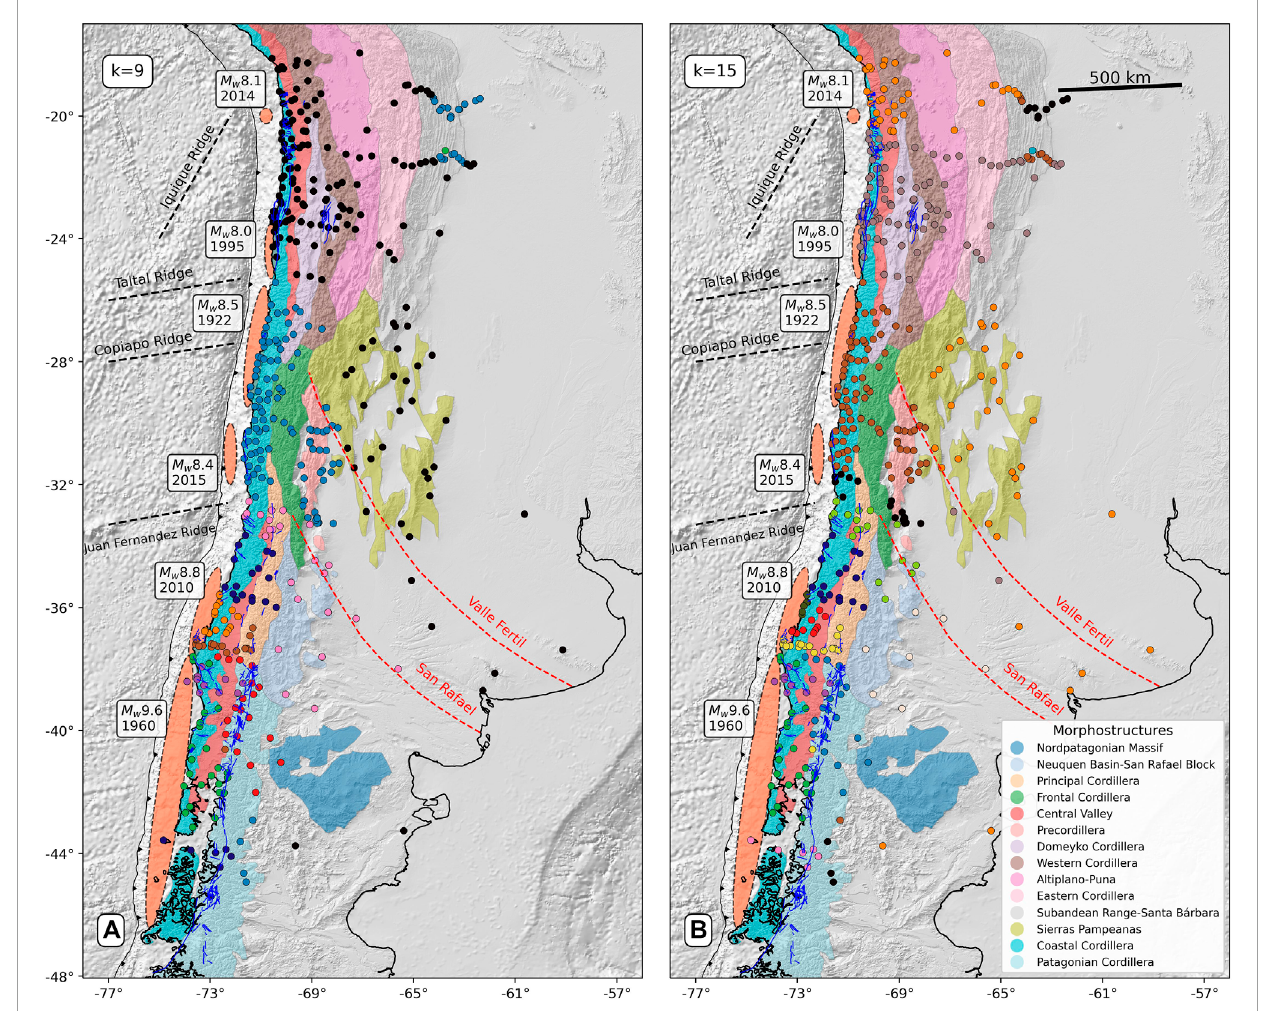
FIGURE 8 Clustering by I 1 , I 3 and w z for the period pre-2014 with k = 9 (A) and k = 15 (B) . Blue lines represents faults traces from (Maldonado et al., 2021). Colored regions represents the morphostructures. Orange ellipses represent the approximate rupture area of the earthquakes from the last 100 years in the region (Delouis et al., 1997; Beck, 1998; Ruiz et al., 2016). Dotted red lines represents the Valle Fertil and San Rafael lineaments of (Jacques, 2003).